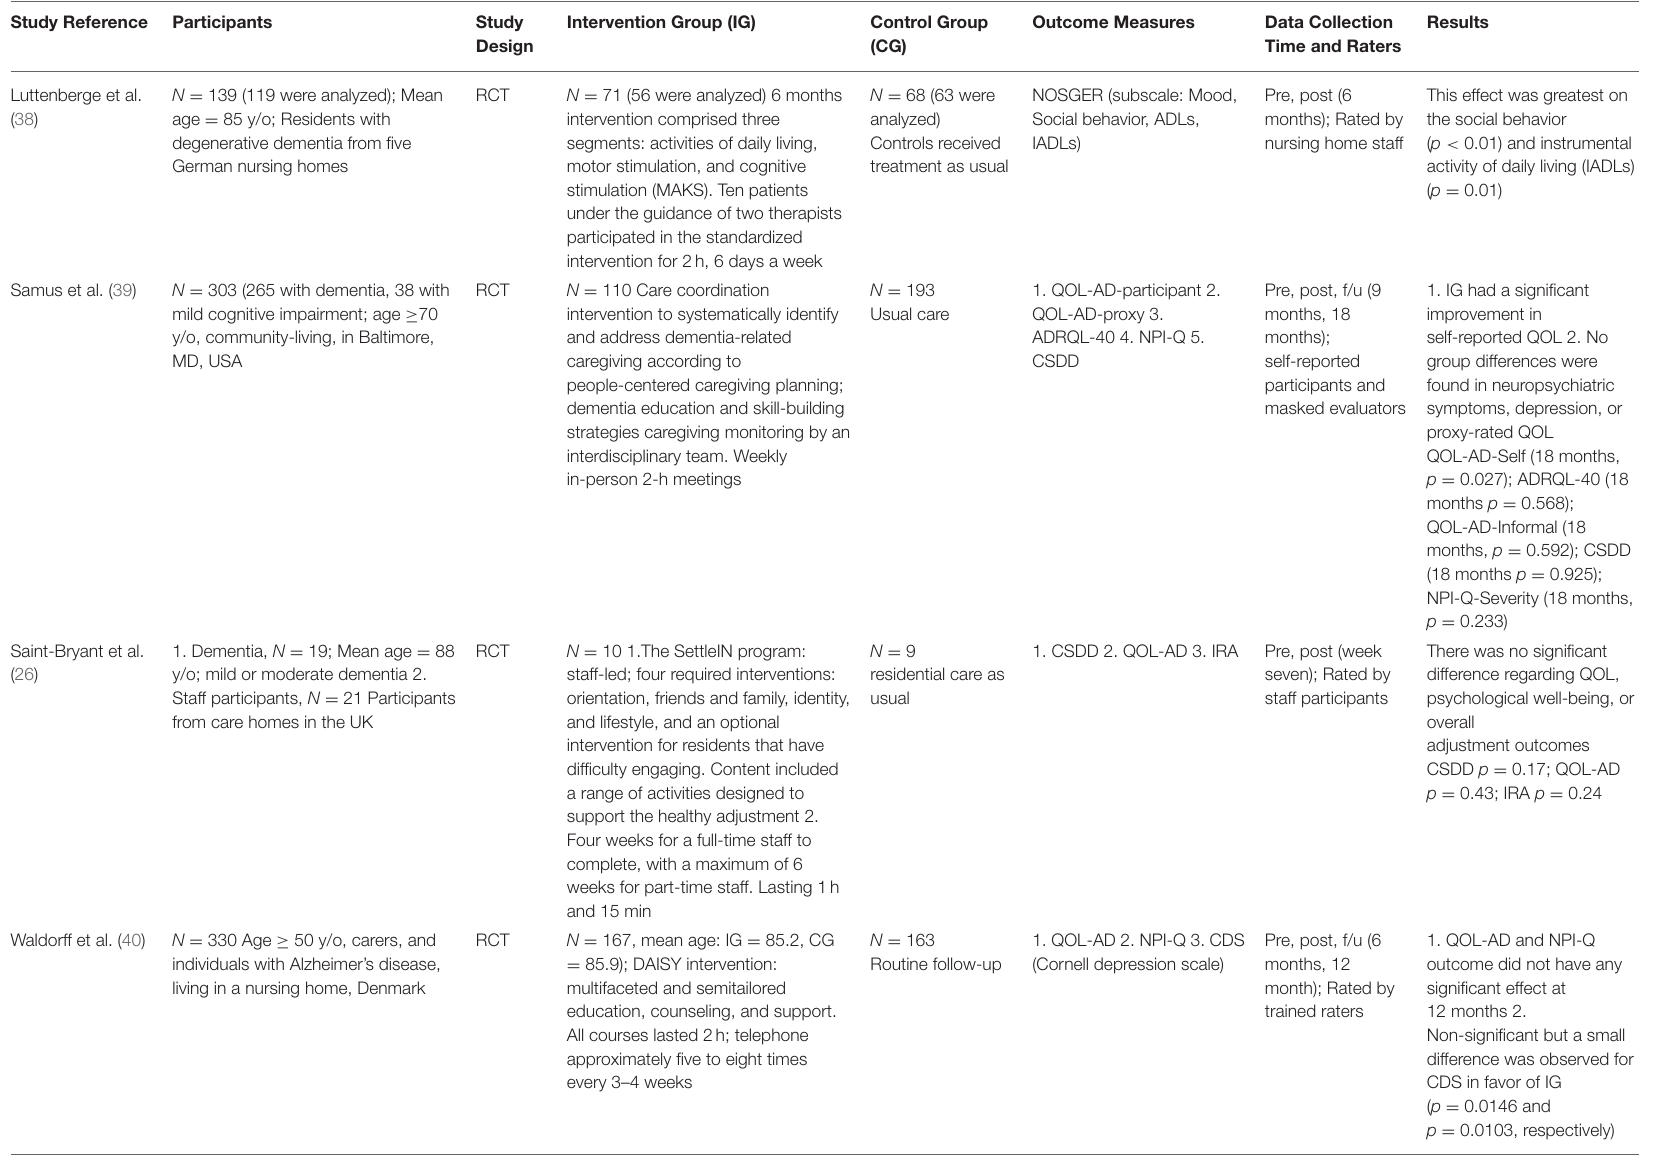
TABLE 1 | Characteristics of included studies. Study Reference